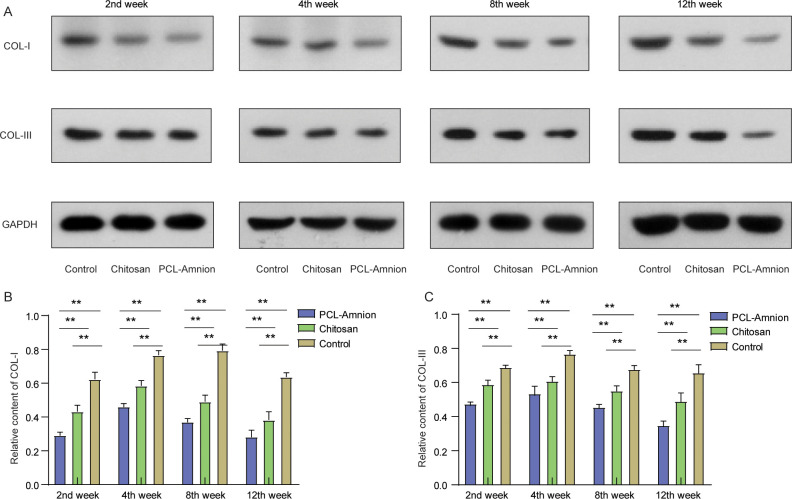
The relative contents of COL-I and III at each time point.(A) Expressions of COL-I and COL-III were detected by western blot. (B) The relative contents of COL-I were compared among the three groups. (C) The relative contents of COL-III were compared among the three groups. **P < 0.01.